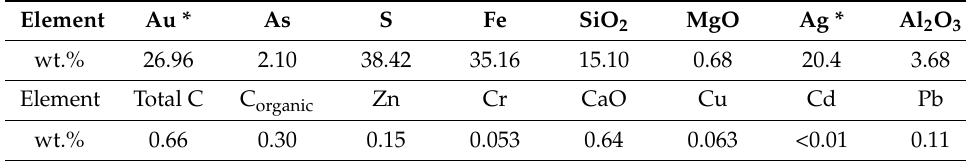
Table 1. Elemental analyses of the gold concentrate samples.